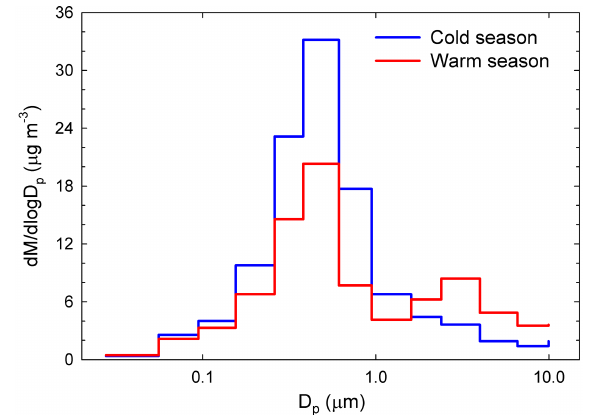
Figure 3. Size distribution histograms of aerosol particle mass con- centration gravimetrically determined over both the cold and warm